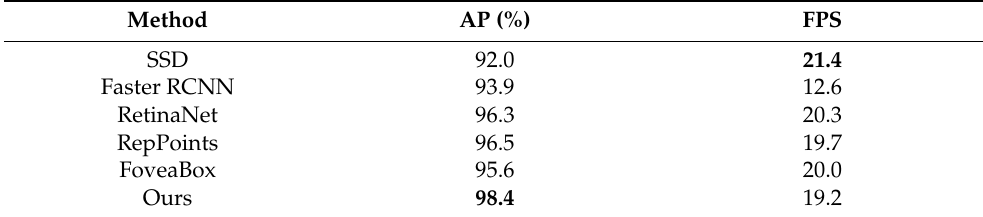
Table 3. The evaluation metrics of different methods on SSDD.